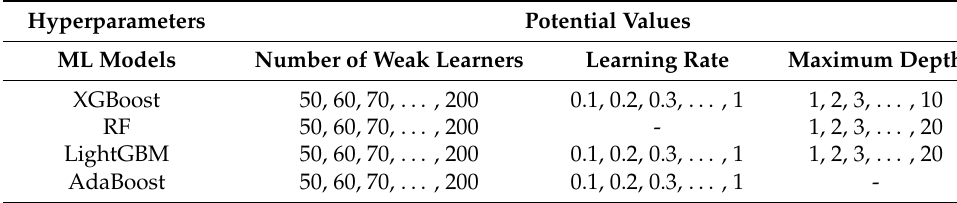
Table 1. The potential values of major hyperparameters of the machine learning model.